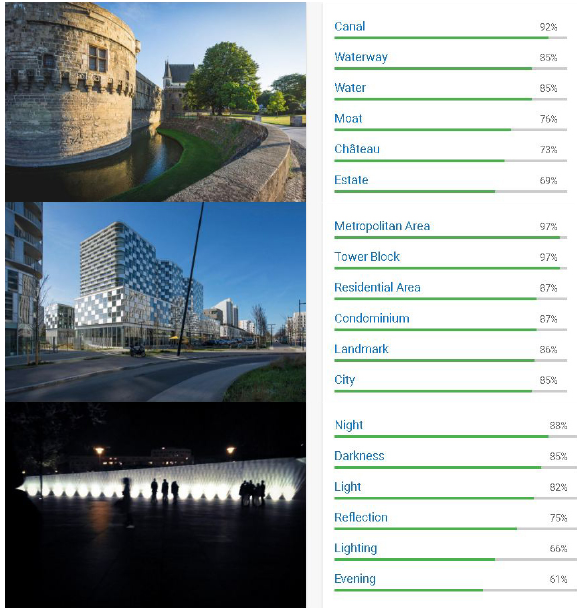
Figure 11. Image type detection samples (Images from